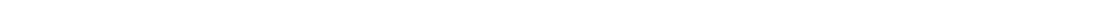
Fig. 6 Assembling process of PPV 12 - b -P2VP n in 2-PrOH solution. a , b The morphology factor R g / R h ( ρ ) of PPV 12 - b -P2VP 22 in 0.05 mg ml − 1 2-PrOH solution after aging for 2 days was calculated to be 1.36 by DLS and SLS. The root mean square radius of gyration ( R g ) is calculated by measuring SLS results of PPV 12 - b -P2VP 22 in 0.05 mg ml − 1 2-PrOH solution at different angles and determined through Berry Plot a , and the hydrodynamic radius ( R h ) was calculated by measuring D h θ of the sample solution at different angles by DLS and extrapolating the value b . Detailed calculation process was described in Methods part. c Plots of the solution temperature versus morphology factor R g / R h ( ρ ) of formed PPV 12 - b -P2VP 22 aggregations in 0.05 mg ml − 1 2-PrOH solution. d 2D GIWAXS pattern and e GIWAXS pro fi les along the in-plane direction of platelet 2-D square micelles obtained from PPV 12 - b -P2VP 22 in 0.05 mg ml − 1 2-PrOH solution. The data cut in the plot was caused by the gap of the detector. f Molecular dynamics simulations of the assembly states in platelet 2-D square micelles of PPV 12 - b -P2VP 12 . The left one is the fi nal self-assembled structure after simulation in isopropanol, and the solvent molecules are not shown for clarity. The right one is a local display of two neighborhood molecules in assembled structure. g Illustration of growing process of platelet 2-D square micelles of PPV 12 - b -P2VP